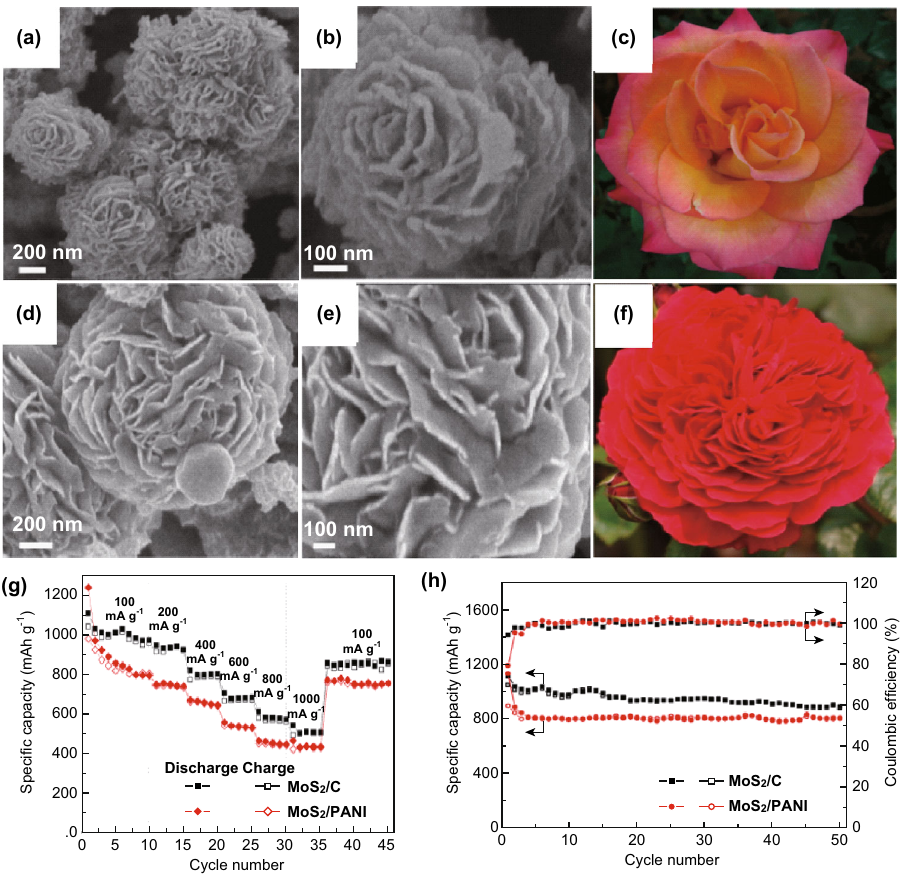
Fig. 5 3D architectures based on 2D transition metal nanoflake self-assemblies for LIBs. SEM images of 3D hierarchical MoS 2 /PANI ( a , b ) and MoS 2 /C ( d , e ) nanoflowers. Photographs of two types of Chinese roses ( c , f ). g Cycling performance and Coulombic efficiency of 3D hierarchical MoS 2 /PANI and MoS 2 /C nanoflowers measured in the voltage range of 0.005–3.0 V at a current density of 100 mA g - 1 . h Rate capability of 3D hierarchical MoS 2 /PANI and MoS 2 /C nanoflowers between 0.005 and 3 V at different current densities. Reproduced with permission [89]. Copyright (cid:2) 2014, American Chemical